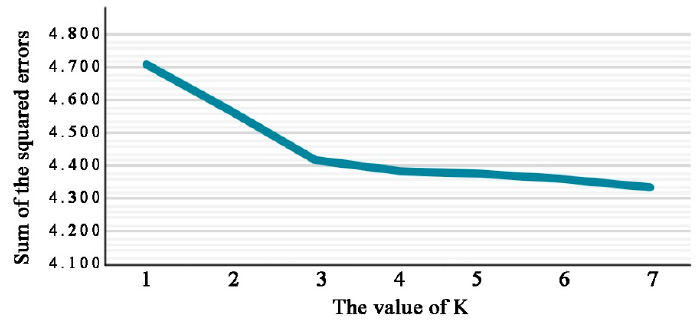
Figure 4. The K- SSE (sum of the squared errors) curve. Figure 4. The K ‐ SSE (sum of the squared errors) curve.